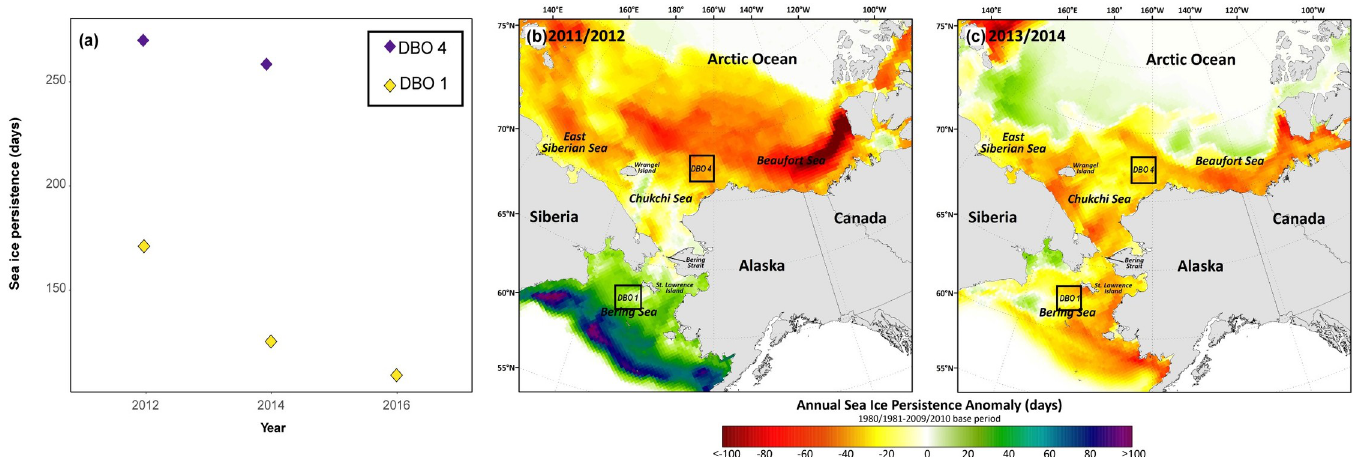
Fig 2. Sea ice persistence in the Pacific Arctic. a) Sea ice persistence (days/year) by year for the northern Bering Sea and Chukchi Sea, b) Sea ice persistence anomalies for 2012 (15 September 2011–14 September 2012), c) Sea ice persistence anomalies for 2014 (15 September 2013–14 September 2014). Made with Natural Earth coastline data. Sea ice persistence anomalies initiate in September for the preceding calendar year to include sea ice formation and retreat in one sea ice season and were compared to a 1980/1981-2009/2010 base period.